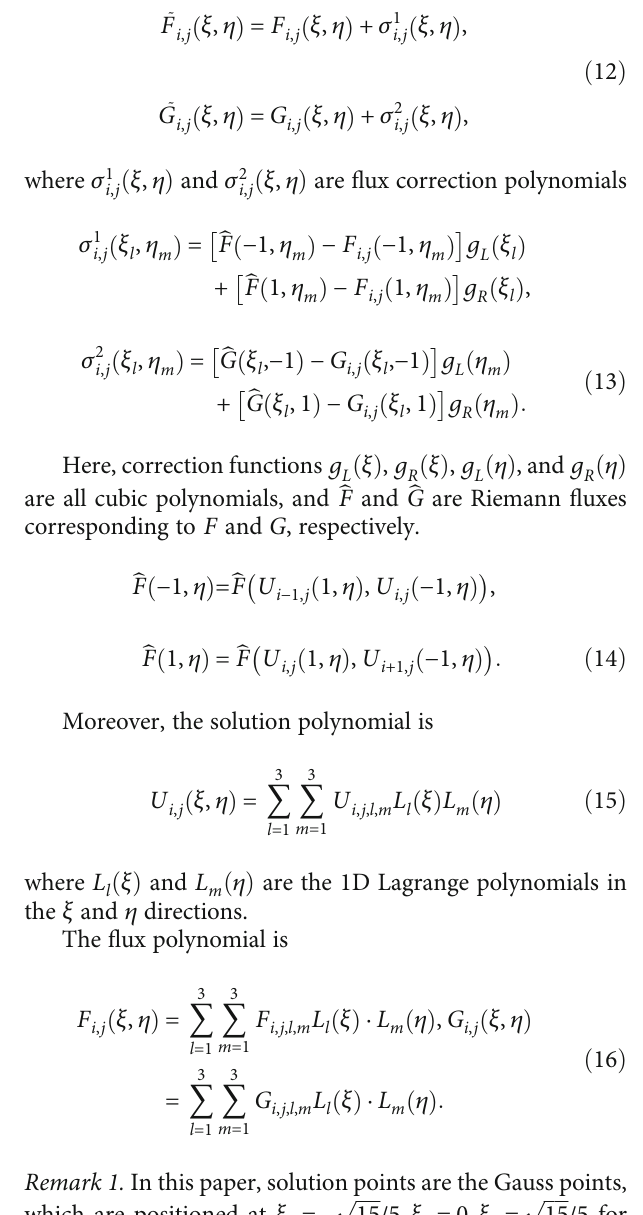
Figure 1: Distribution of solution points and fl ux points of 2D WCNS in ð i , j Þ -th cell. Solution points are marked in blue dot and fl ux points in orange